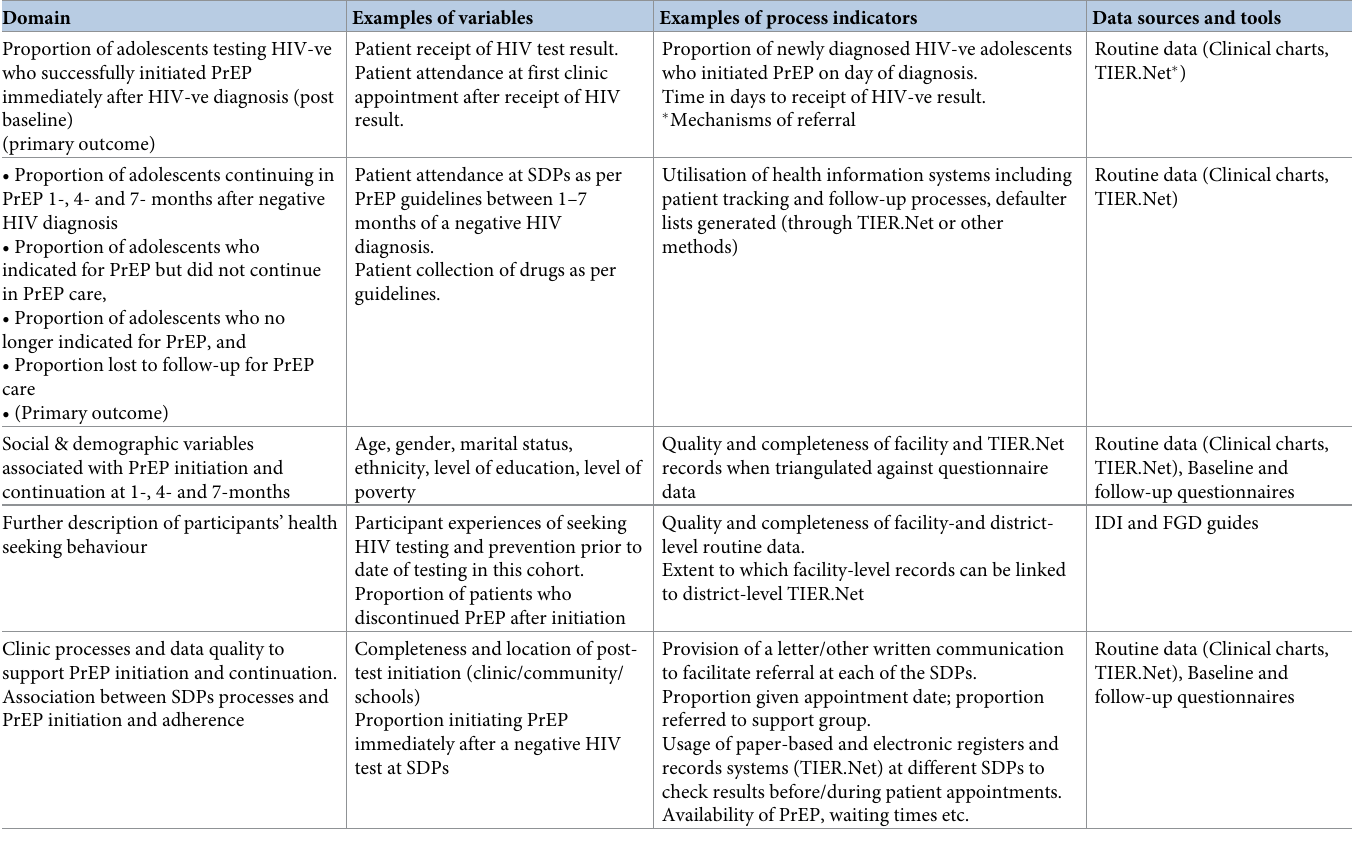
Table 4. Roles of outcome variables in the SHeS’Cap-PrEP study in uMgungundlovu district, KZN, 2021. Domain Examples of variables Examples of process indicators Data sources and